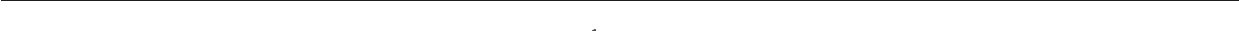
Fig. 3 Molecular structure of GSH stabilizers at the CdTe NP surface. 1 H NMR spectra of a GSH at pH = 10.0, b Cd x (GSH) y complexes, c Hydrogel-544, d Hydrogel-590, and e Hydrogel-618. Amino acid residues in GSH are indicated by a single-letter code: Glutamyl, Q; Glycinyl, G; Cysteinyl, C. f Two-dimensional 1 H – 1 H ROESY spectrum of Hydrogel-544. Schematic representations of g the three-point bonding (TPB) mode and h the single-point bonding (SPB) mode between GSH and the edge and face of a CdTe NP, respectively. The two bonding modes are clearly visible in the NMR spectra ( b – e ) as indicated by the symbol (star) for TPB and symbol (triangle) for SPB. Measurements of the density of GSH indicate that only one layer of GSH is present around each NP, so ligands attached to the particle surfaces are also participating in the gel